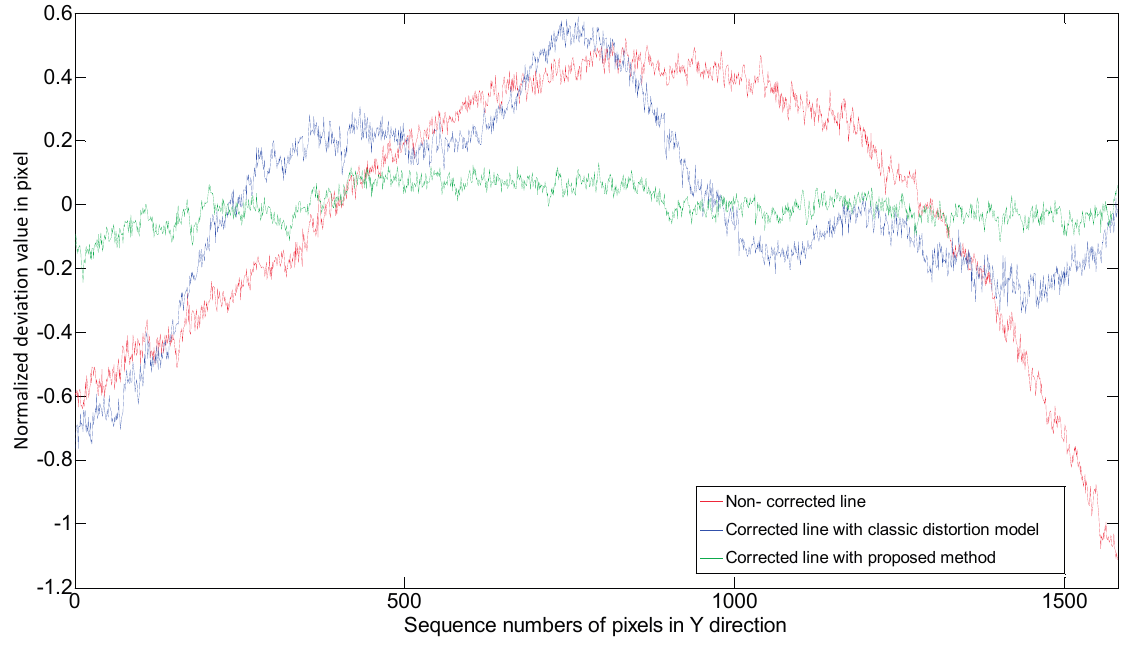
Figure 9. Evaluation results on non-linear